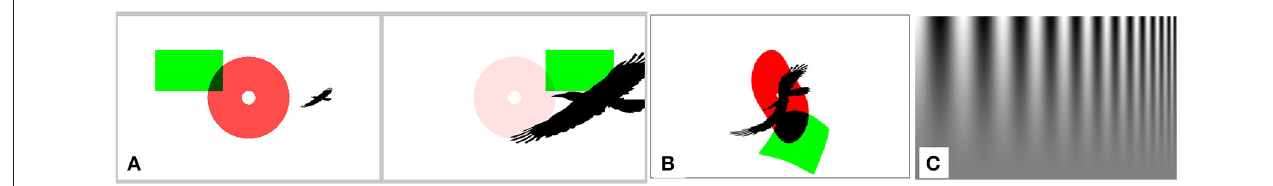
FIGURE 5 | Simple shapes and patterns in GEARS. (A) Two frames from a stimulus displaying shapes with changing size and intensity. (B) Shapes under non-linear pinch-twist distortion. (C) Campbell-Robertson pattern with frequency and contrast